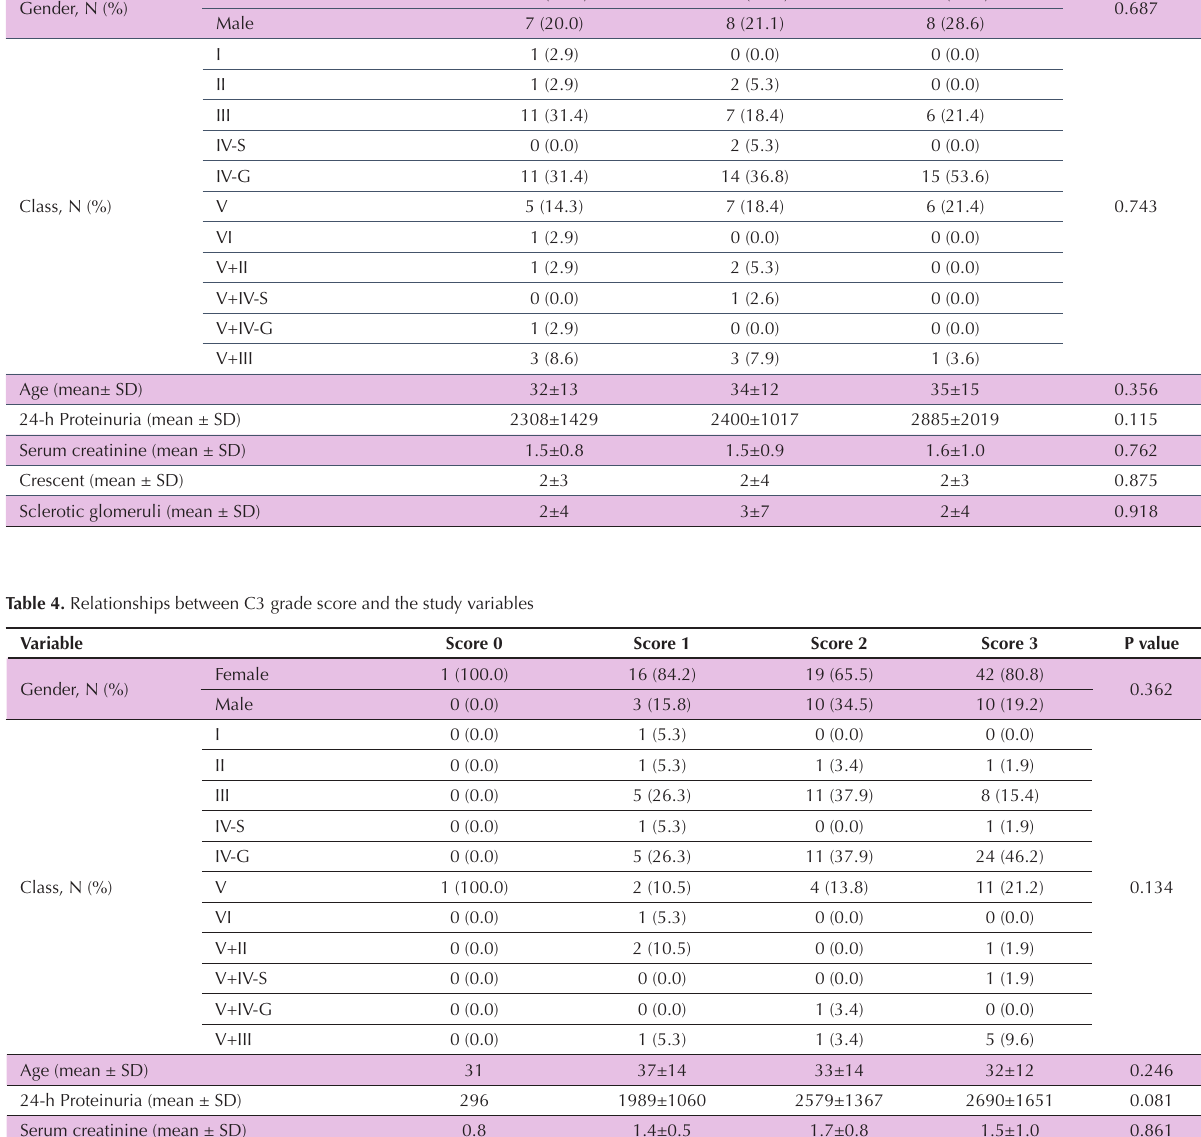
Table 3. Relationships between IgM grade and the study variables Variable